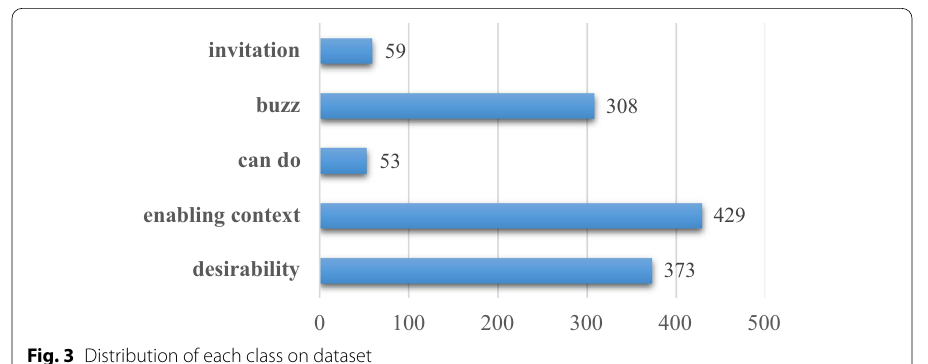
Fig. 3 Distribution of each class on dataset